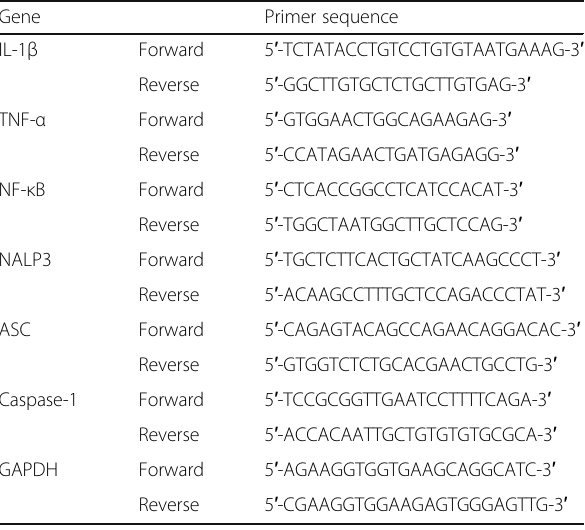
Table 1 Real-time PCR primer